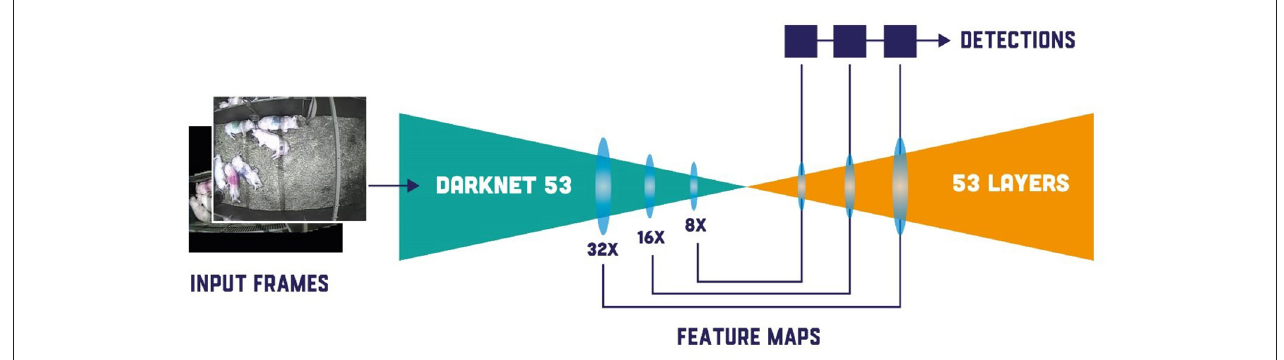
FIGURE 2 | Graphical overview of You Only Look Once v3